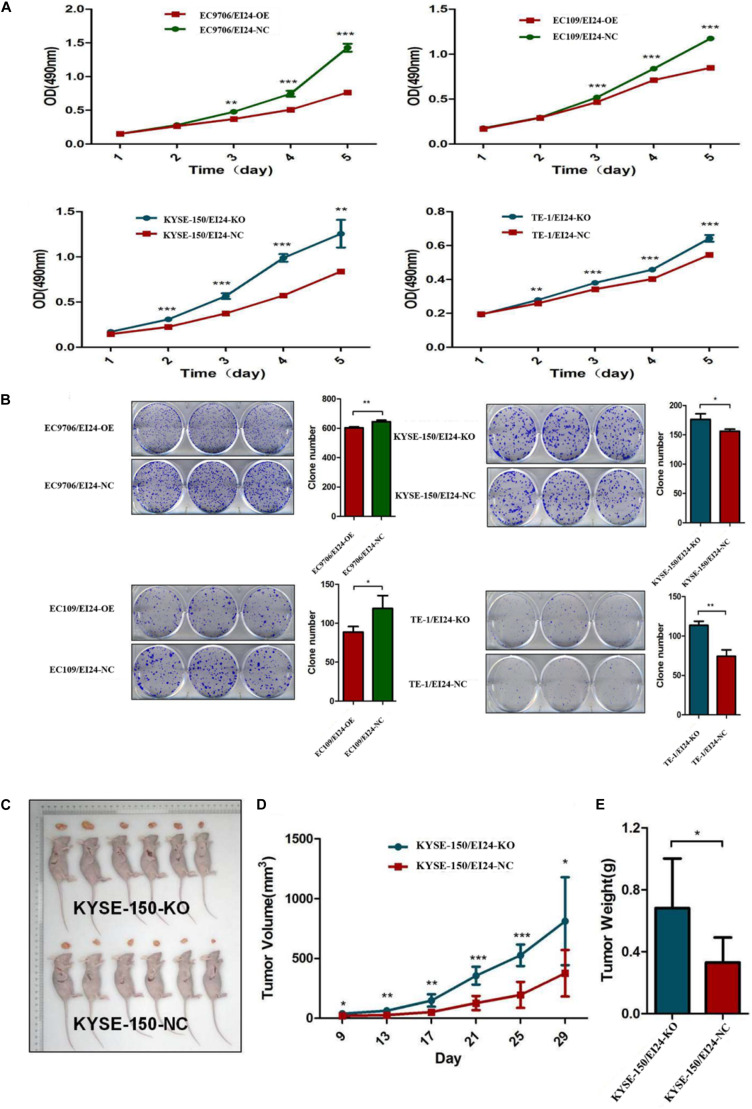
Effects of EI24 knockdown or overexpression on cell proliferation in vitro and in vivo. (A,B) MTT proliferation assay and colony formation assay were used for detecting the proliferation ability in EI24-knockdown or EI24-overexpressing ESCC cell lines; EI24 silencing significantly promoted the growth of xenografts in comparison with the NC group. Cells were injected into the hindlimbs of nude mice (n = 6). (C) Representative images of tumor-bearing mice and tumors isolated from tumor-bearing mice. (D) Tumor growth curves were measured during the growth of the tumors. Tumors derived from KYSE150 cells expressing EI24-KO grew significantly faster than those from cells with EI24-NC. (E) Final tumor weights were measured in each group. *P < 0.05, **P < 0.01, ***P < 0.001.